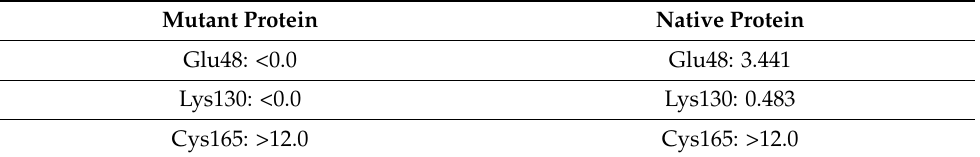
Table 6. The most important residues, pKa, of wild-type and mutant proteins. Mutant